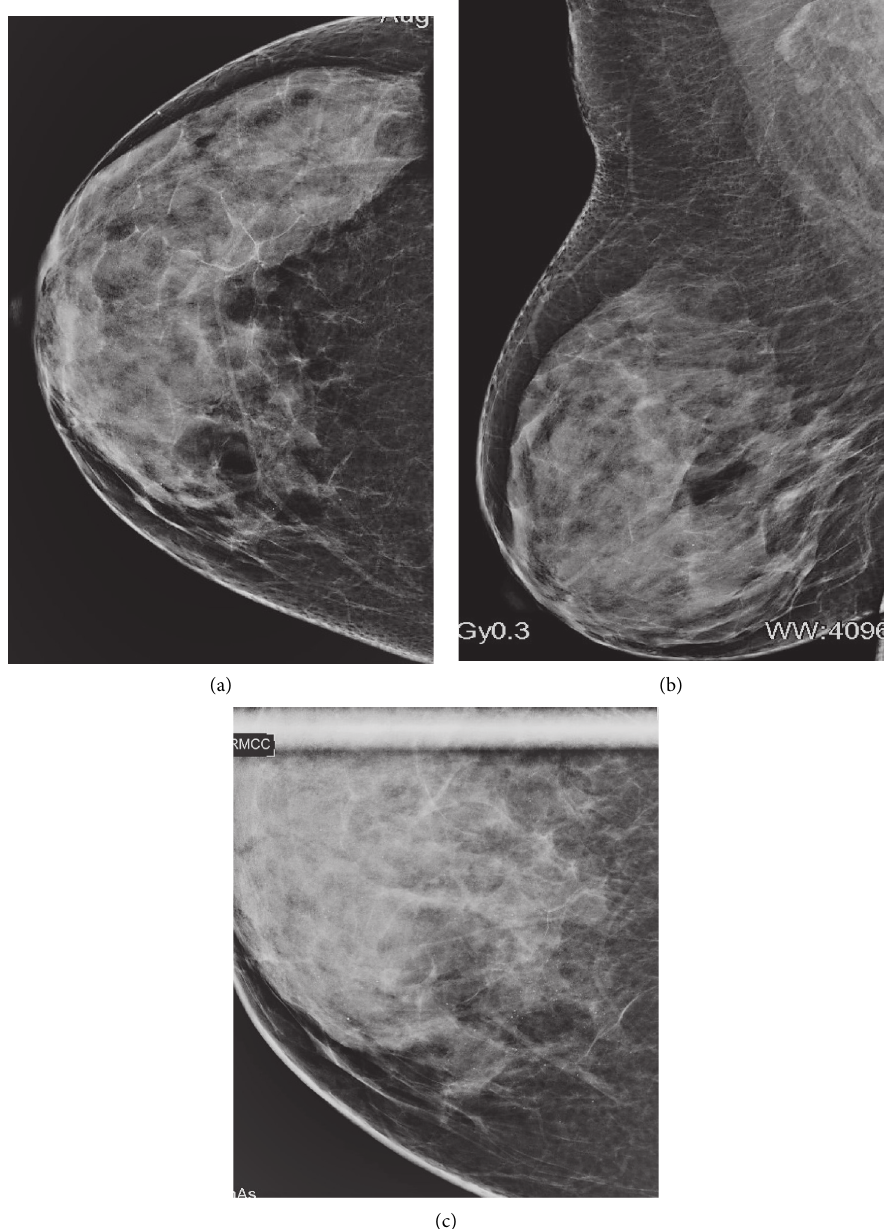
Figure 4: CC, MLO, and magnified CC view of right breast. (a) Biopsy-proven infiltrating ductal carcinoma Her-2 neu enrich tumor. (b) There are suspicious microcalcifications in the lower-outer quadrant which lead us to do a magnified CC view which shows clustered microcalcifications. (c) No definite mass was identified on mammogram as well as on ultrasound. Sono-mammometry score �